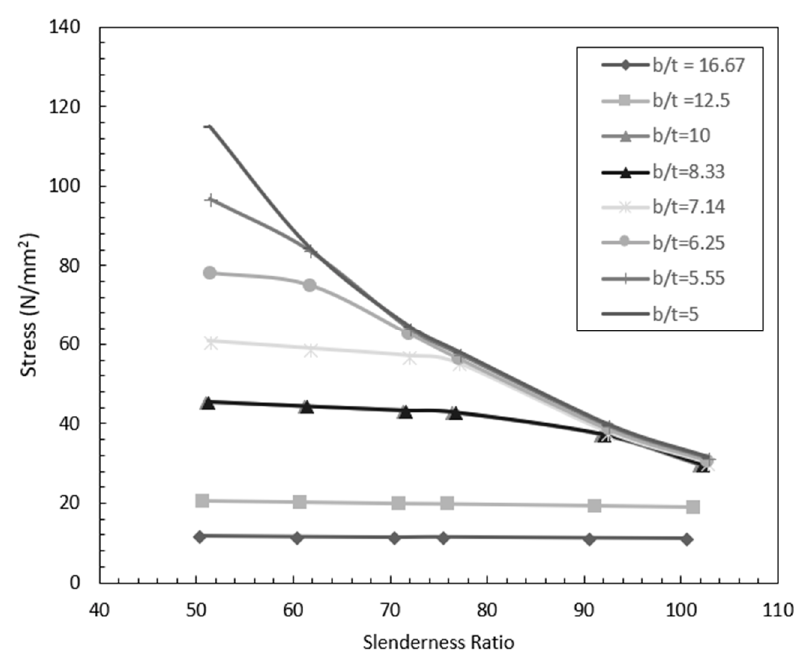
Figure 9. Variation of stress at buckling load with slenderness ratio and width-to-thickness ratio.